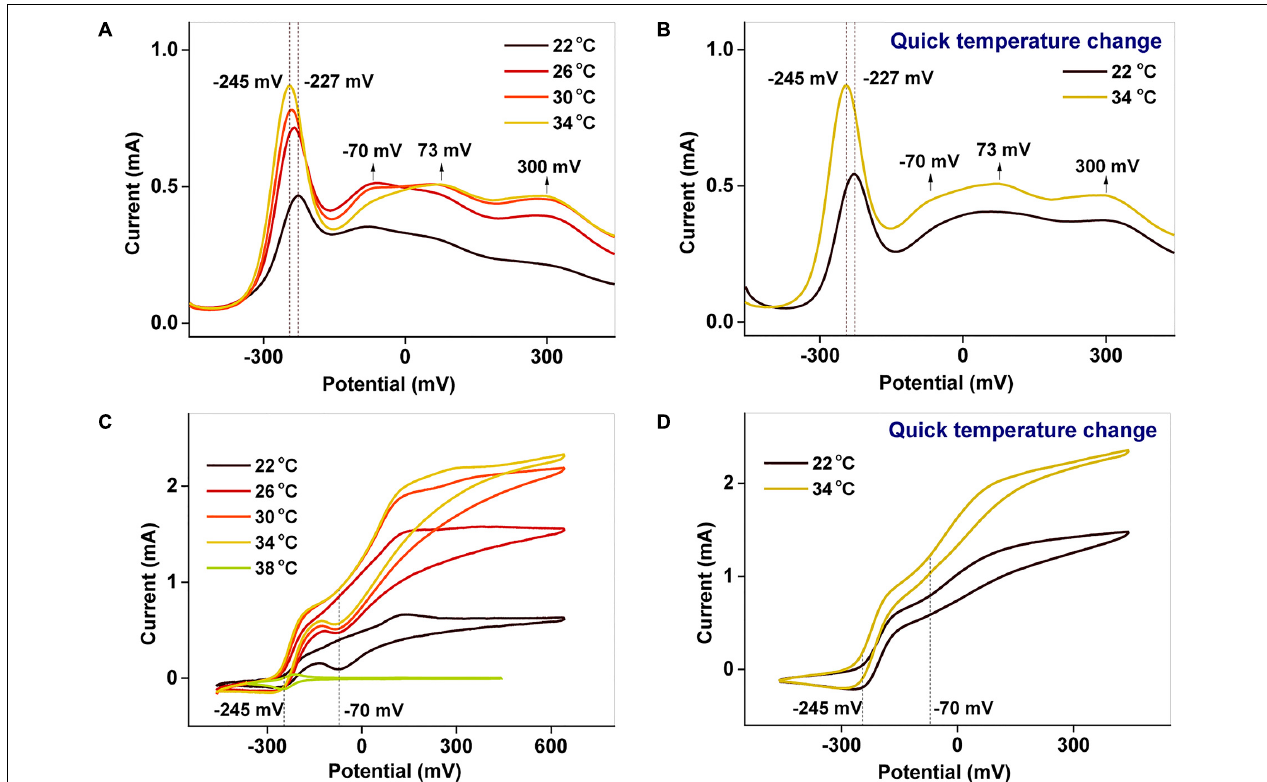
FIGURE 4 | (A,B) DPV and (C,D) CV characterizations of biofilms cultured at different temperatures. In (B,D) , the temperature was suddenly lowered from 34 to 22 ◦ C.